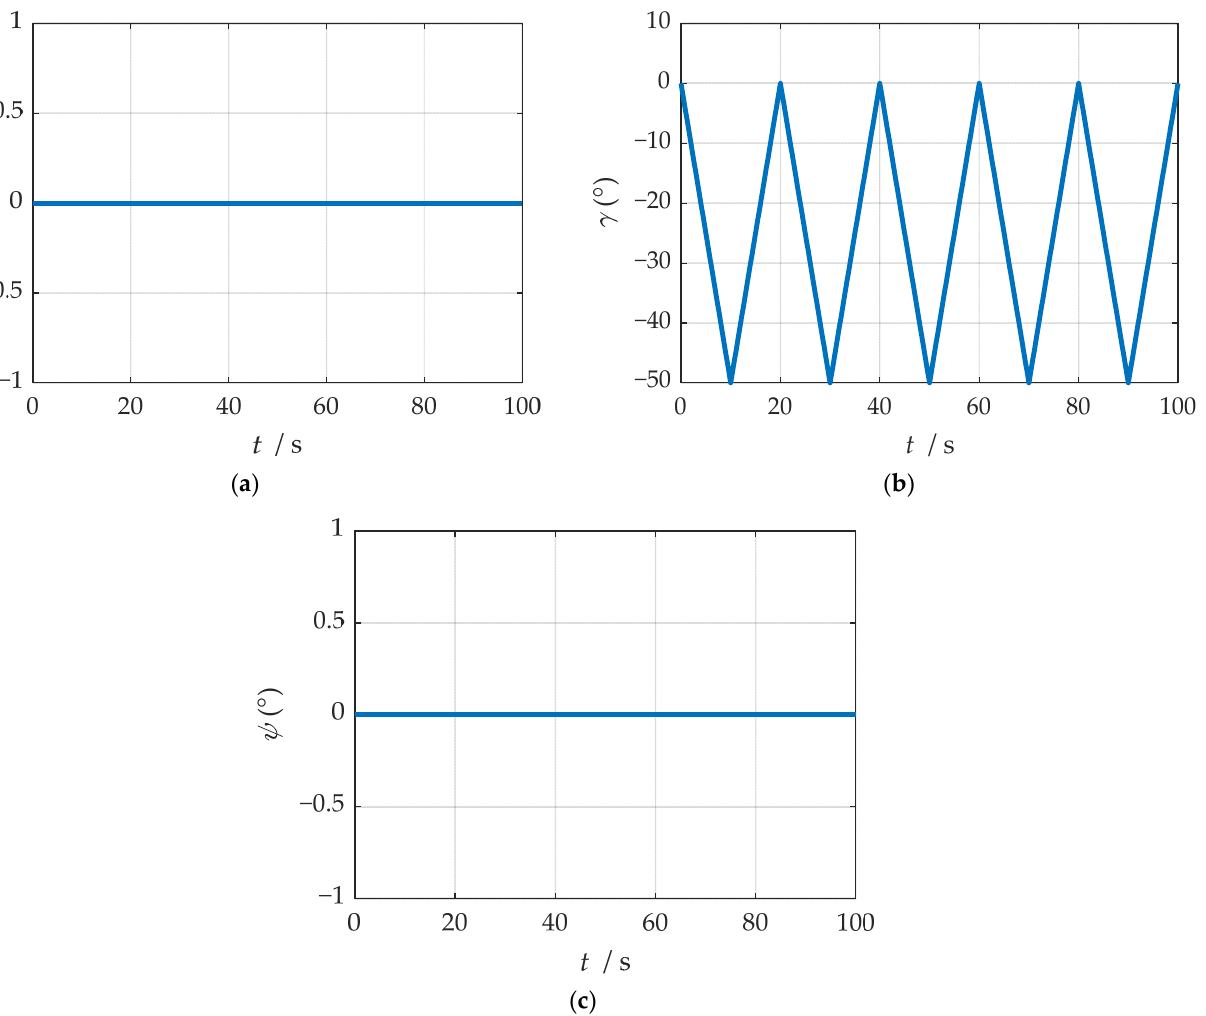
Figure 25. Ideal attitude solution results: ( a ) ideal results of yaw angle; ( b ) ideal results of roll angle; ( c ) ideal results of pitch angle.